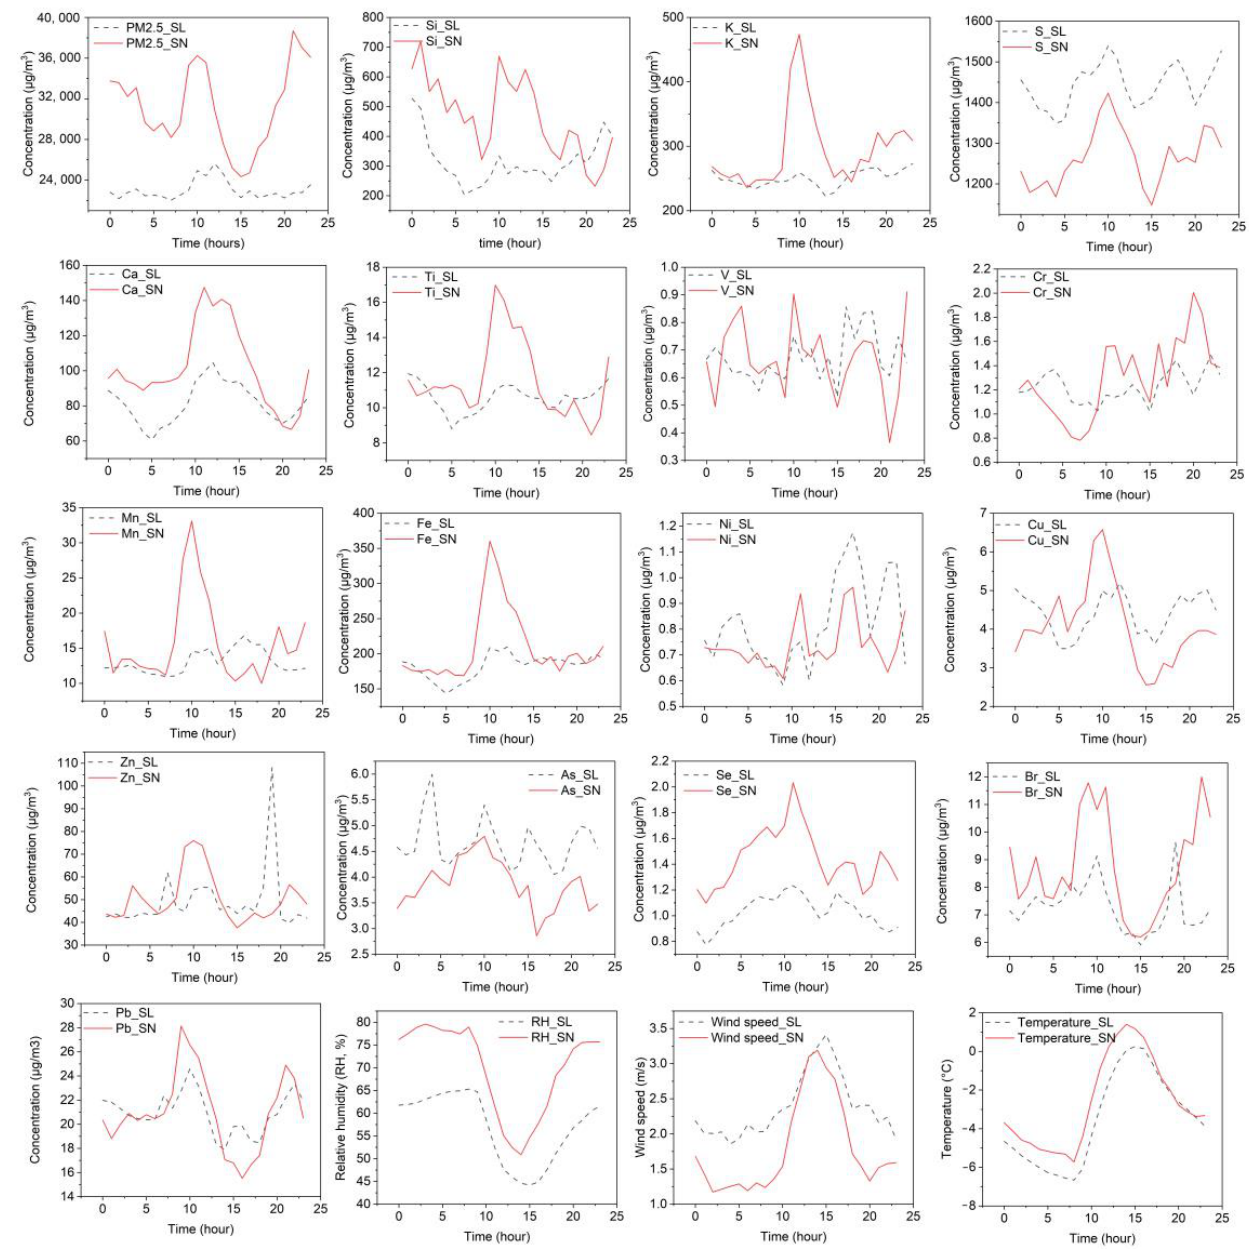
Figure 1. Hourly variations in concentrations of PM 2.5 , elements, and meteorological parameters in Seoul (SL) and Seosan (SN) during winter.